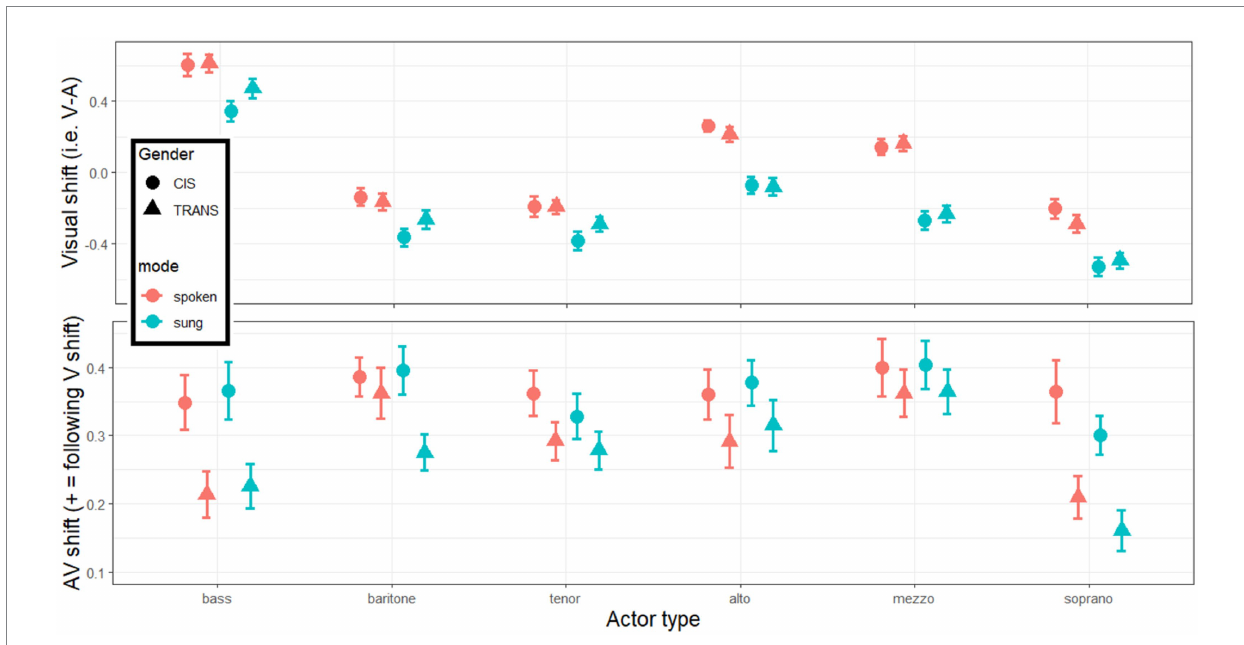
FIGURE 5 Visual shifts (top panels) calculated from the difference V – A ratings in each category of actors, each mode, and each group of listeners. AV shifts (bottom panels) calculated from the difference AV – A ratings multiplied by the sign of V shift so that positive value always indicate a shift toward the visual